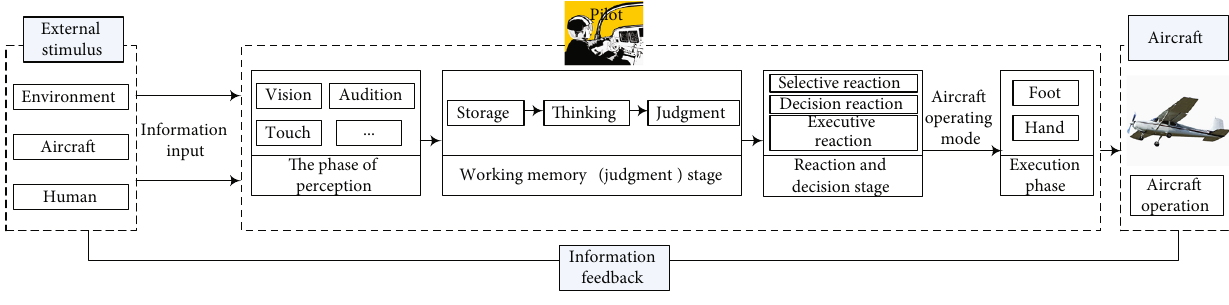
Figure 8: Cognitive process of